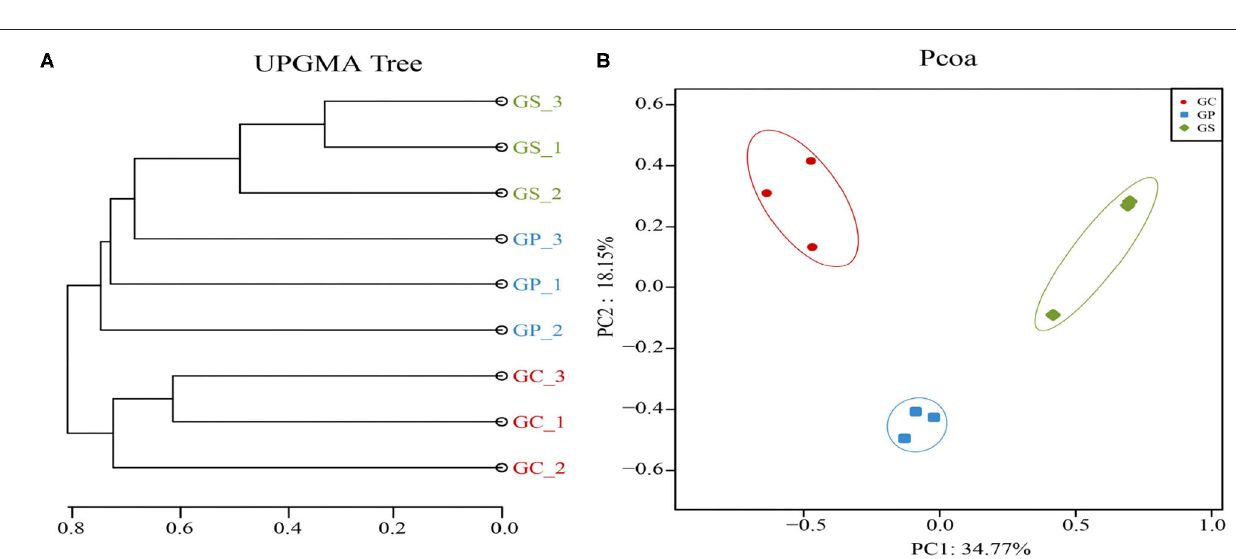
mexD-01, mexW-02, mexB-02, multidrug-transporter-06, mexI- 02, and mexE-02 were related to more than 57 ARGs, which were closely connected nodes, indicating that these genes could be used as indicator genes for ARGs. In addition, arnA